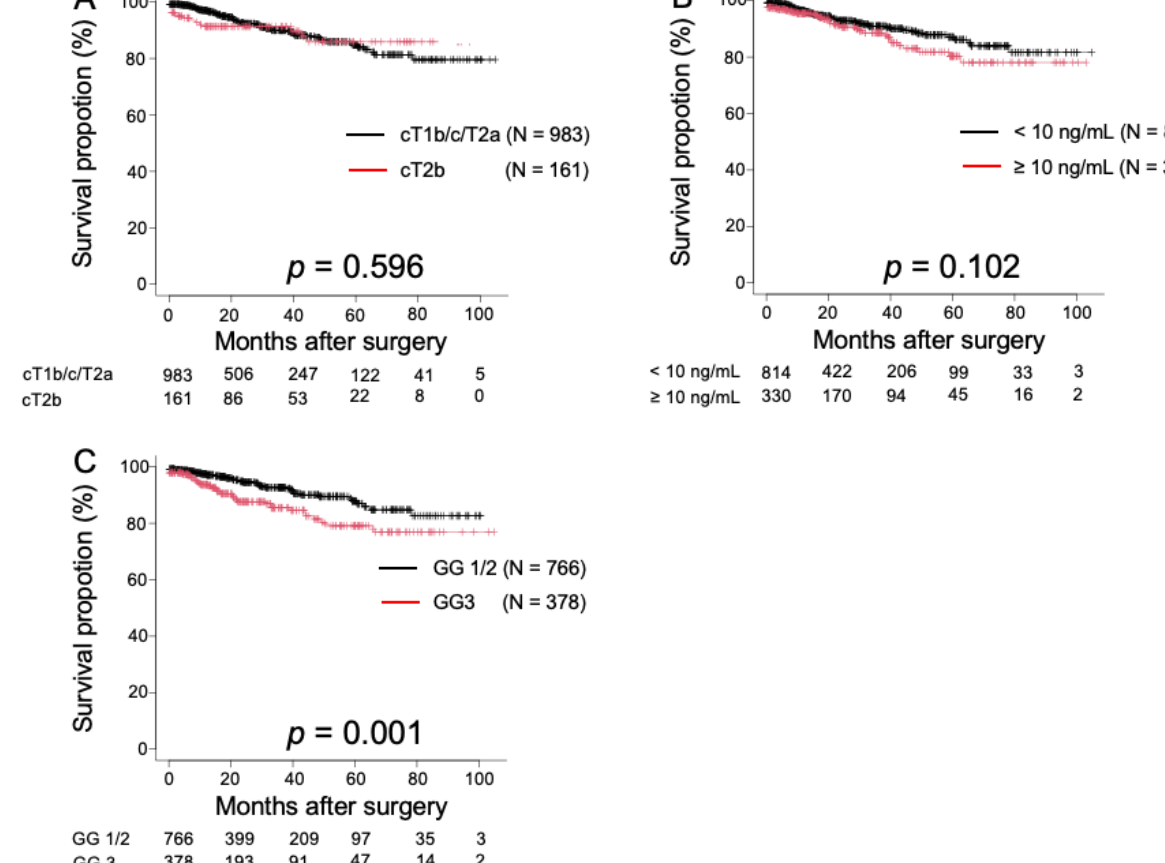
Figure 1. Kaplan–Meier estimates of biochemical recurrence-free survival (BRFS) according to clinical T stage ( A ), initial prostate-specific antigen (PSA) levels, which were stratified by a cutoff of 10 ng/dL ( B ), and the biopsy Gleason grade (GG) ( C ). The 2 year BRFS rates were 92.3% and 91.3% in patients with clinical T1/2a and clinical T2b, respectively ( p = 0.596; Figure 1A); 92.8% and 90.6% in patients with an initial PSA level of <10 ng/mL and ≥ 10 ng/mL, respectively ( p = 0.102; Figure 1B); and 94.5% and 87.6% in patients with biopsy GG of 1/2 and GG of 3, respectively ( p = 0.001; Figure 1C).